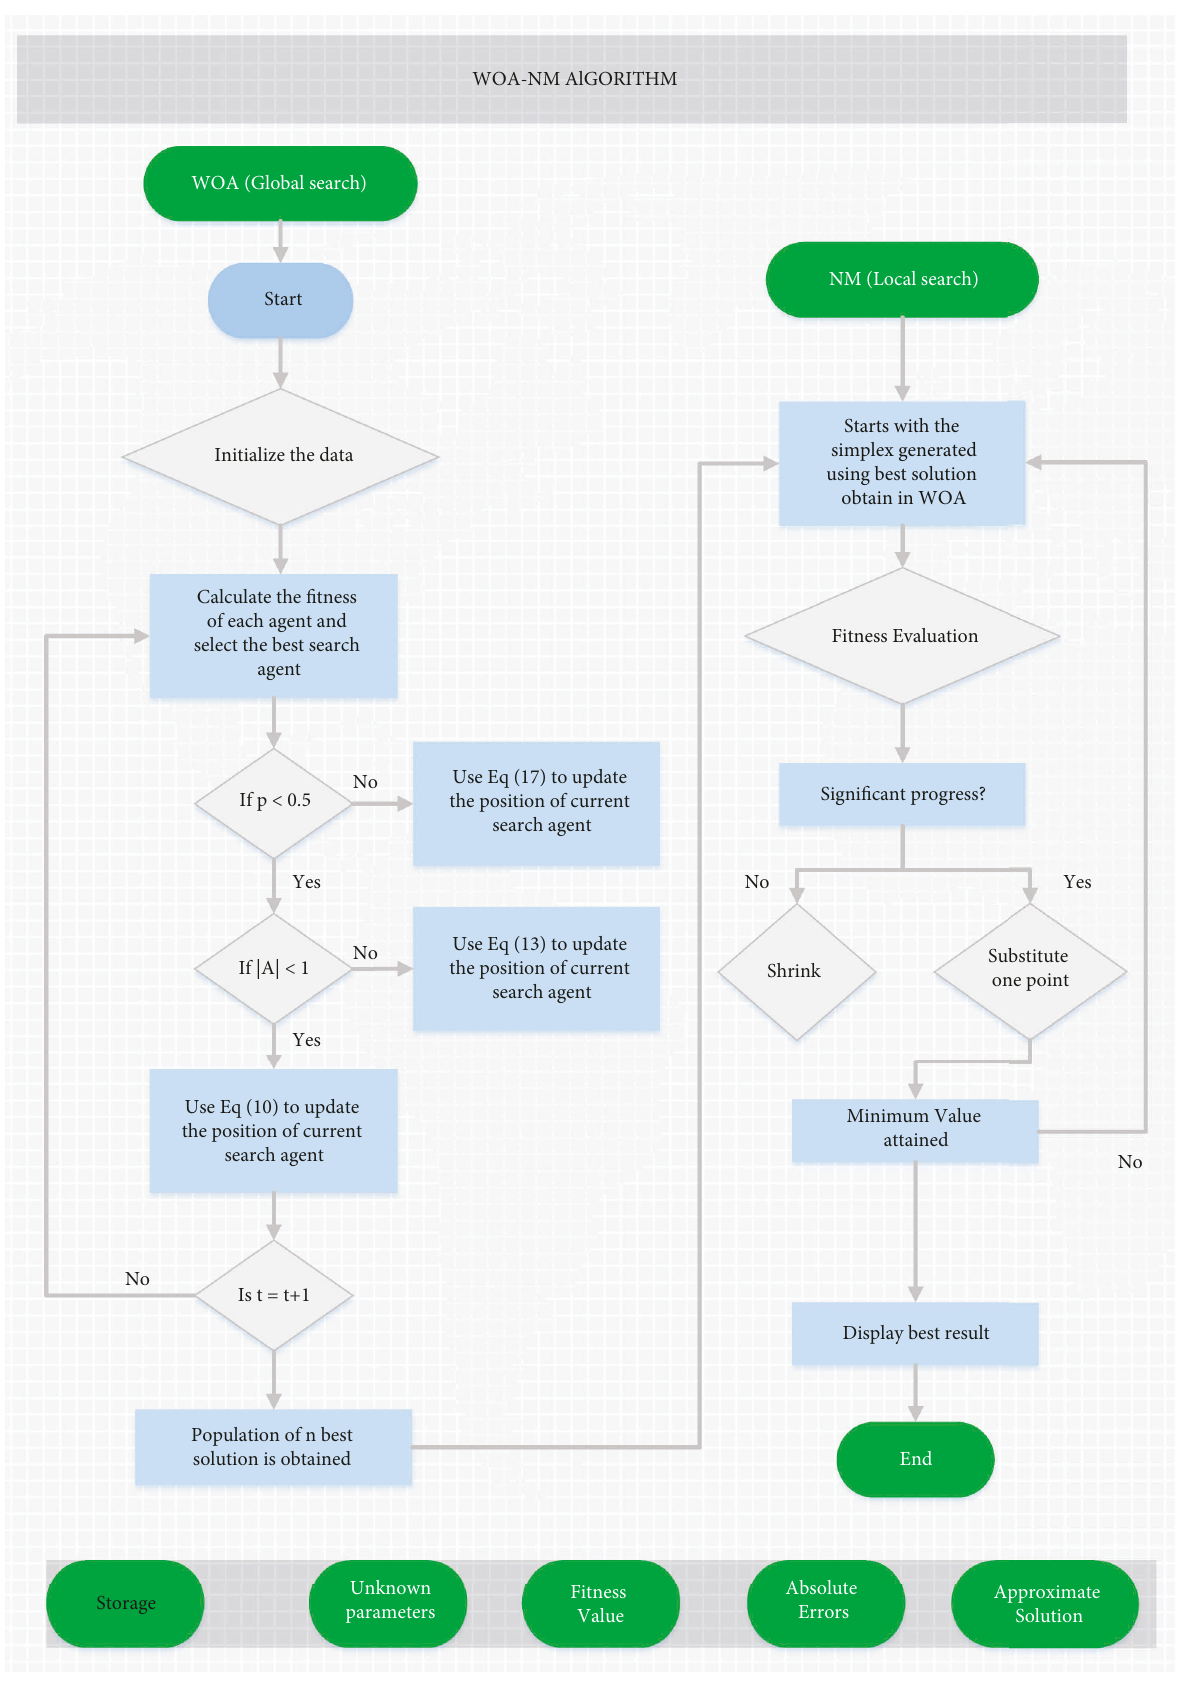
Figure 2: Graphical illustration of the working steps of the whale optimization algorithm and Nelder–Mead algorithm for the training of neurons in the LeNN architecture and the minimization of fitness